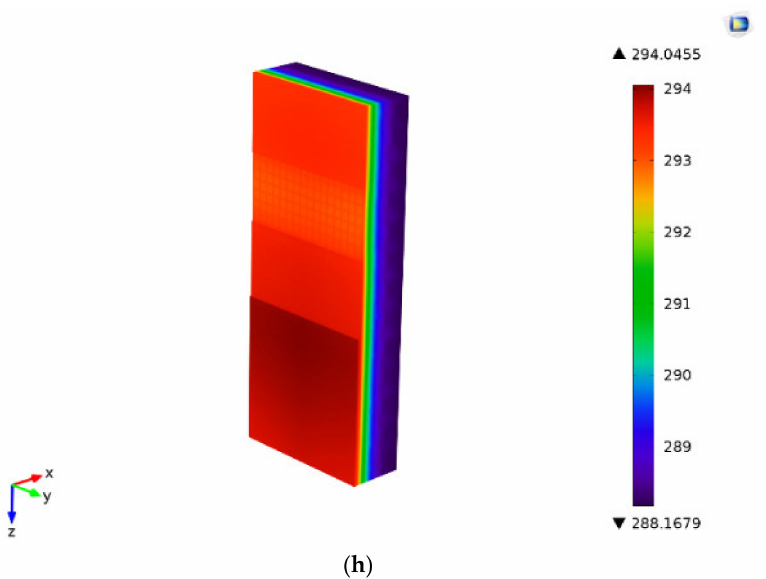
Figure 6. Variations of specimen temperature distribution during the cooling phase (total time in brackets): ( a ) 10 s of cooling (70 s), ( b ) 20 s (80 s), ( c ) 30 s (90 s), ( d ) 60 s (120 s), ( e ) 90 s (150 s), ( f ) 120 s (180 s), ( g ) 150 s (210 s), ( h ) 180 s (240